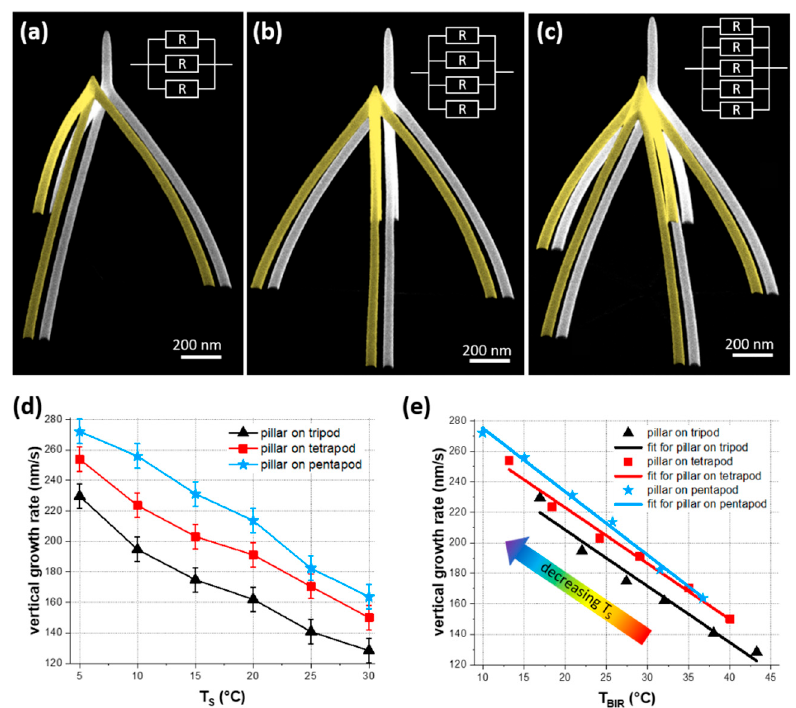
Figure 6. Pillar growth on multipod structures. Collage of tilted SEM images of ( a ) tripods, ( b ) tetrapods and ( c ) pentapods without (yellow) and with additional pillars (white). ( a – c ) were fabricated with a DT of 15 ms at a T S of 30 ◦ C. The respective equivalent circuits for total thermal resistances of all structures is shown on the top right in ( a – c ). The vertical growth rates of the 2.5 s pillars are shown as a function of T S ( d ) and T BIR at the pillar growth front ( e ). The lines in ( e ) give linear fits of the multipods, the colored arrow indicates the trend of T S in the